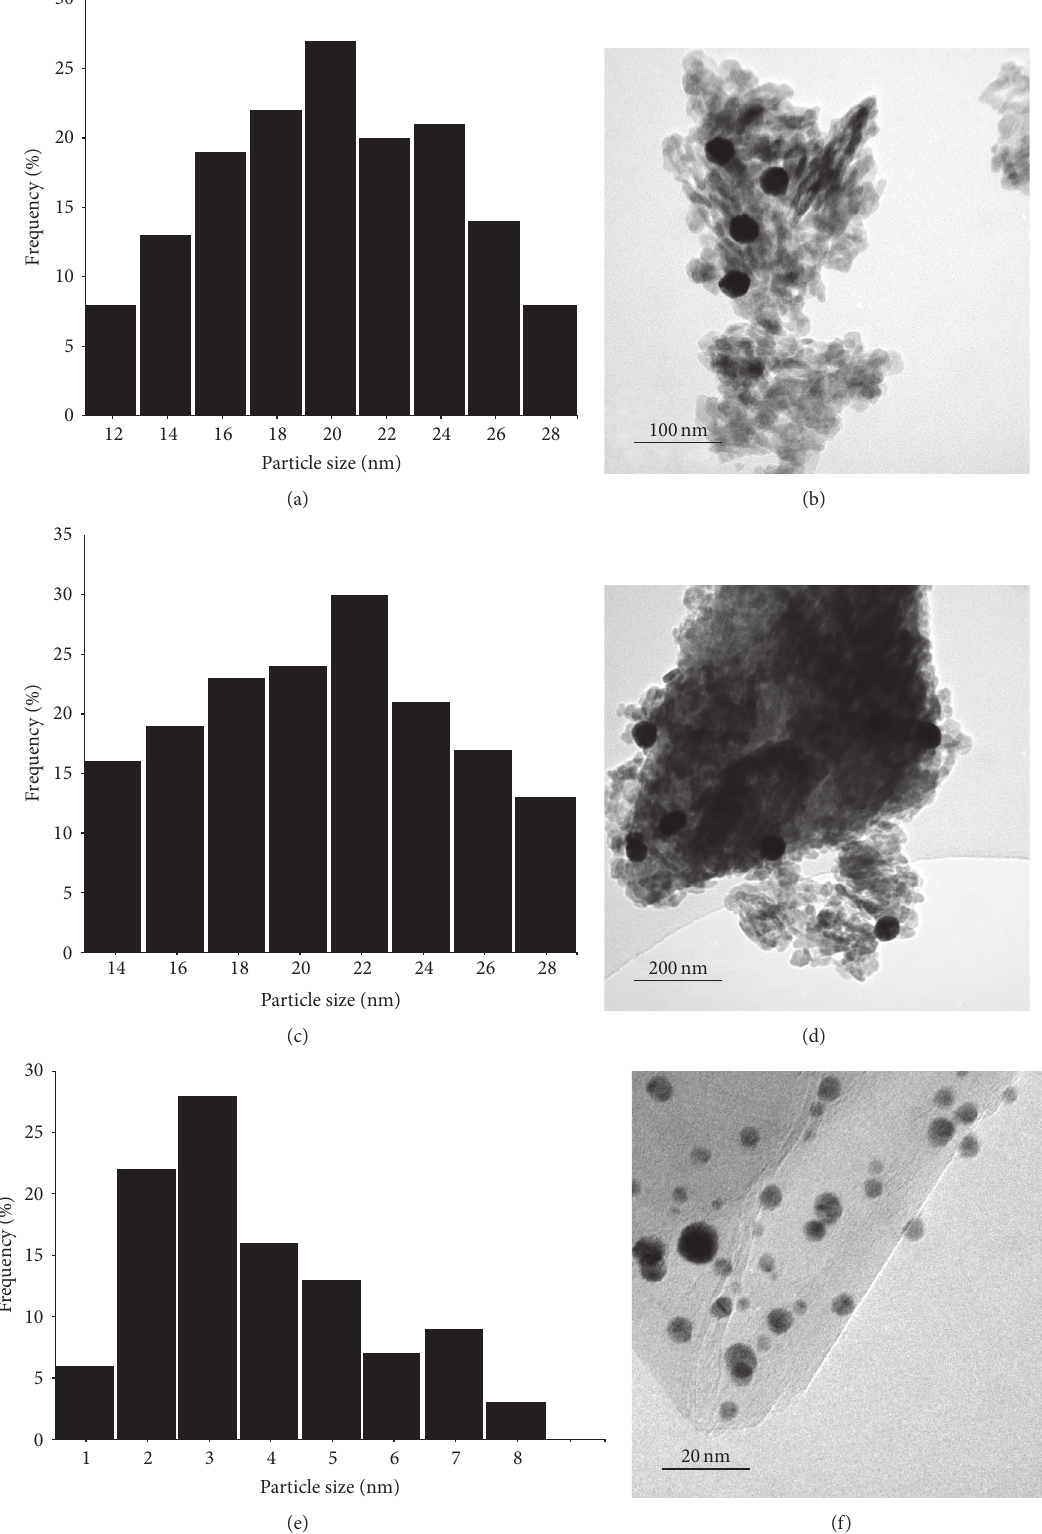
Figure 3: Particle size distributions and TEM image of Au/MnO 2 using different preparation methods, respectively: DP (a) and (b); IM (c) and (d); SI (e) and